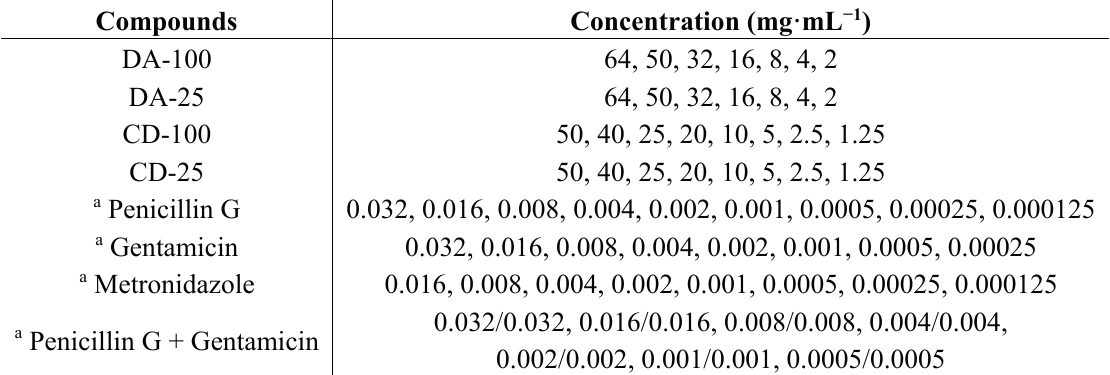
Table 4. Concentrations of compounds used in MIC and MBC